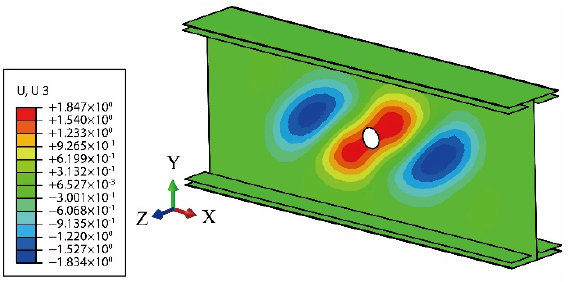
Figure 32. The numerical result of the off-plane deformation in the web region of the BW-II composite beam under the concentrate shear load.